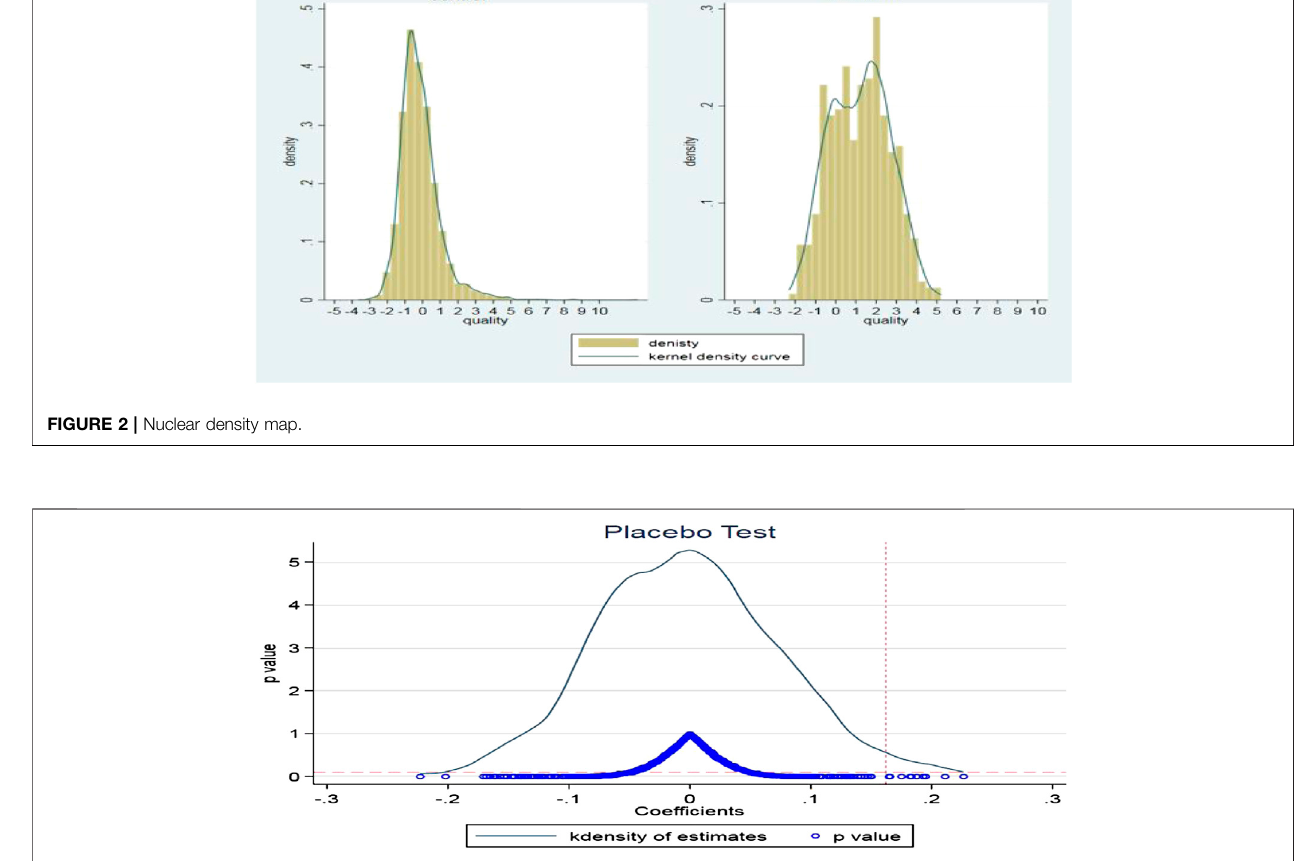
FIGURE 3 | Results of the placebo test.